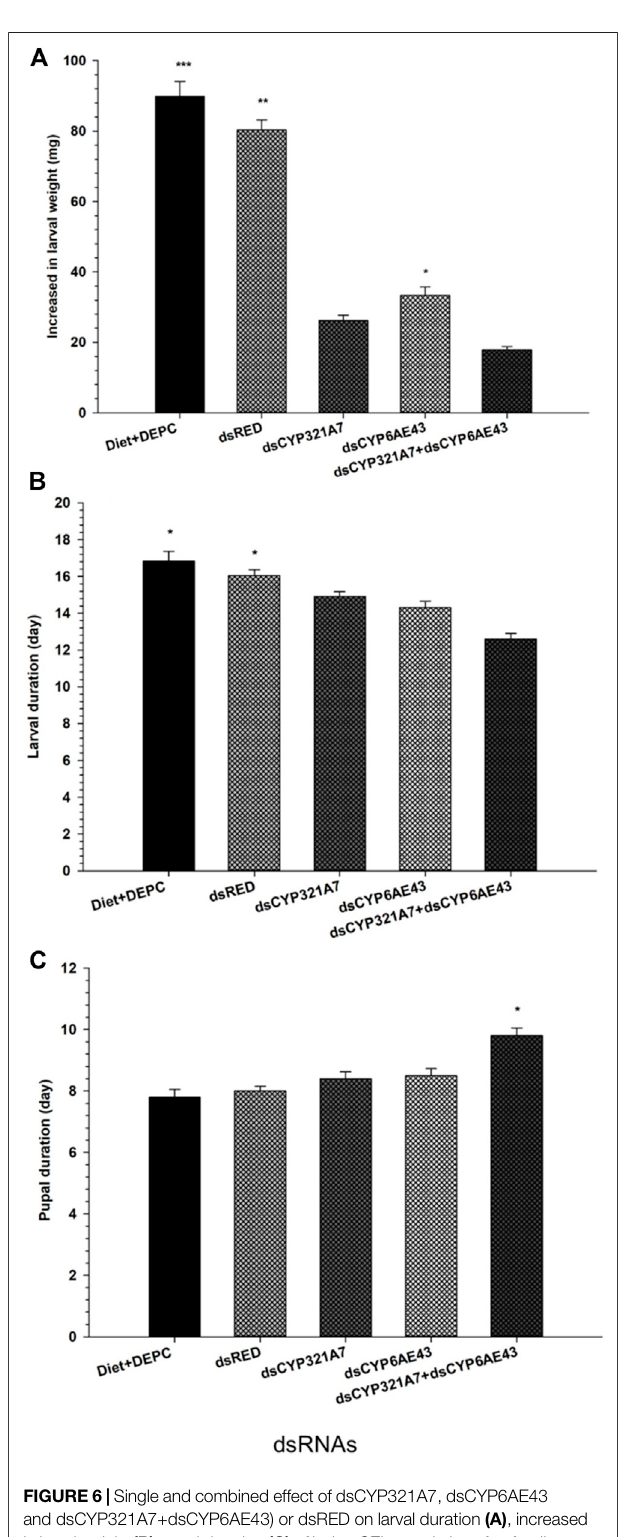
FIGURE 6 | Single and combined effect of dsCYP321A7, dsCYP6AE43 and dsCYP321A7+dsCYP6AE43) or dsRED on larval duration (A) , increased inlarvalweight (B) pupalduration (C) ofIndox-SEL populationafterfeedingon dsRNAs, or the dsRED for 24 h followed by the exposed larvae were transferred individually into 12-oriface tissue culture plate containing arti fi cial dietssupplementedwithLC